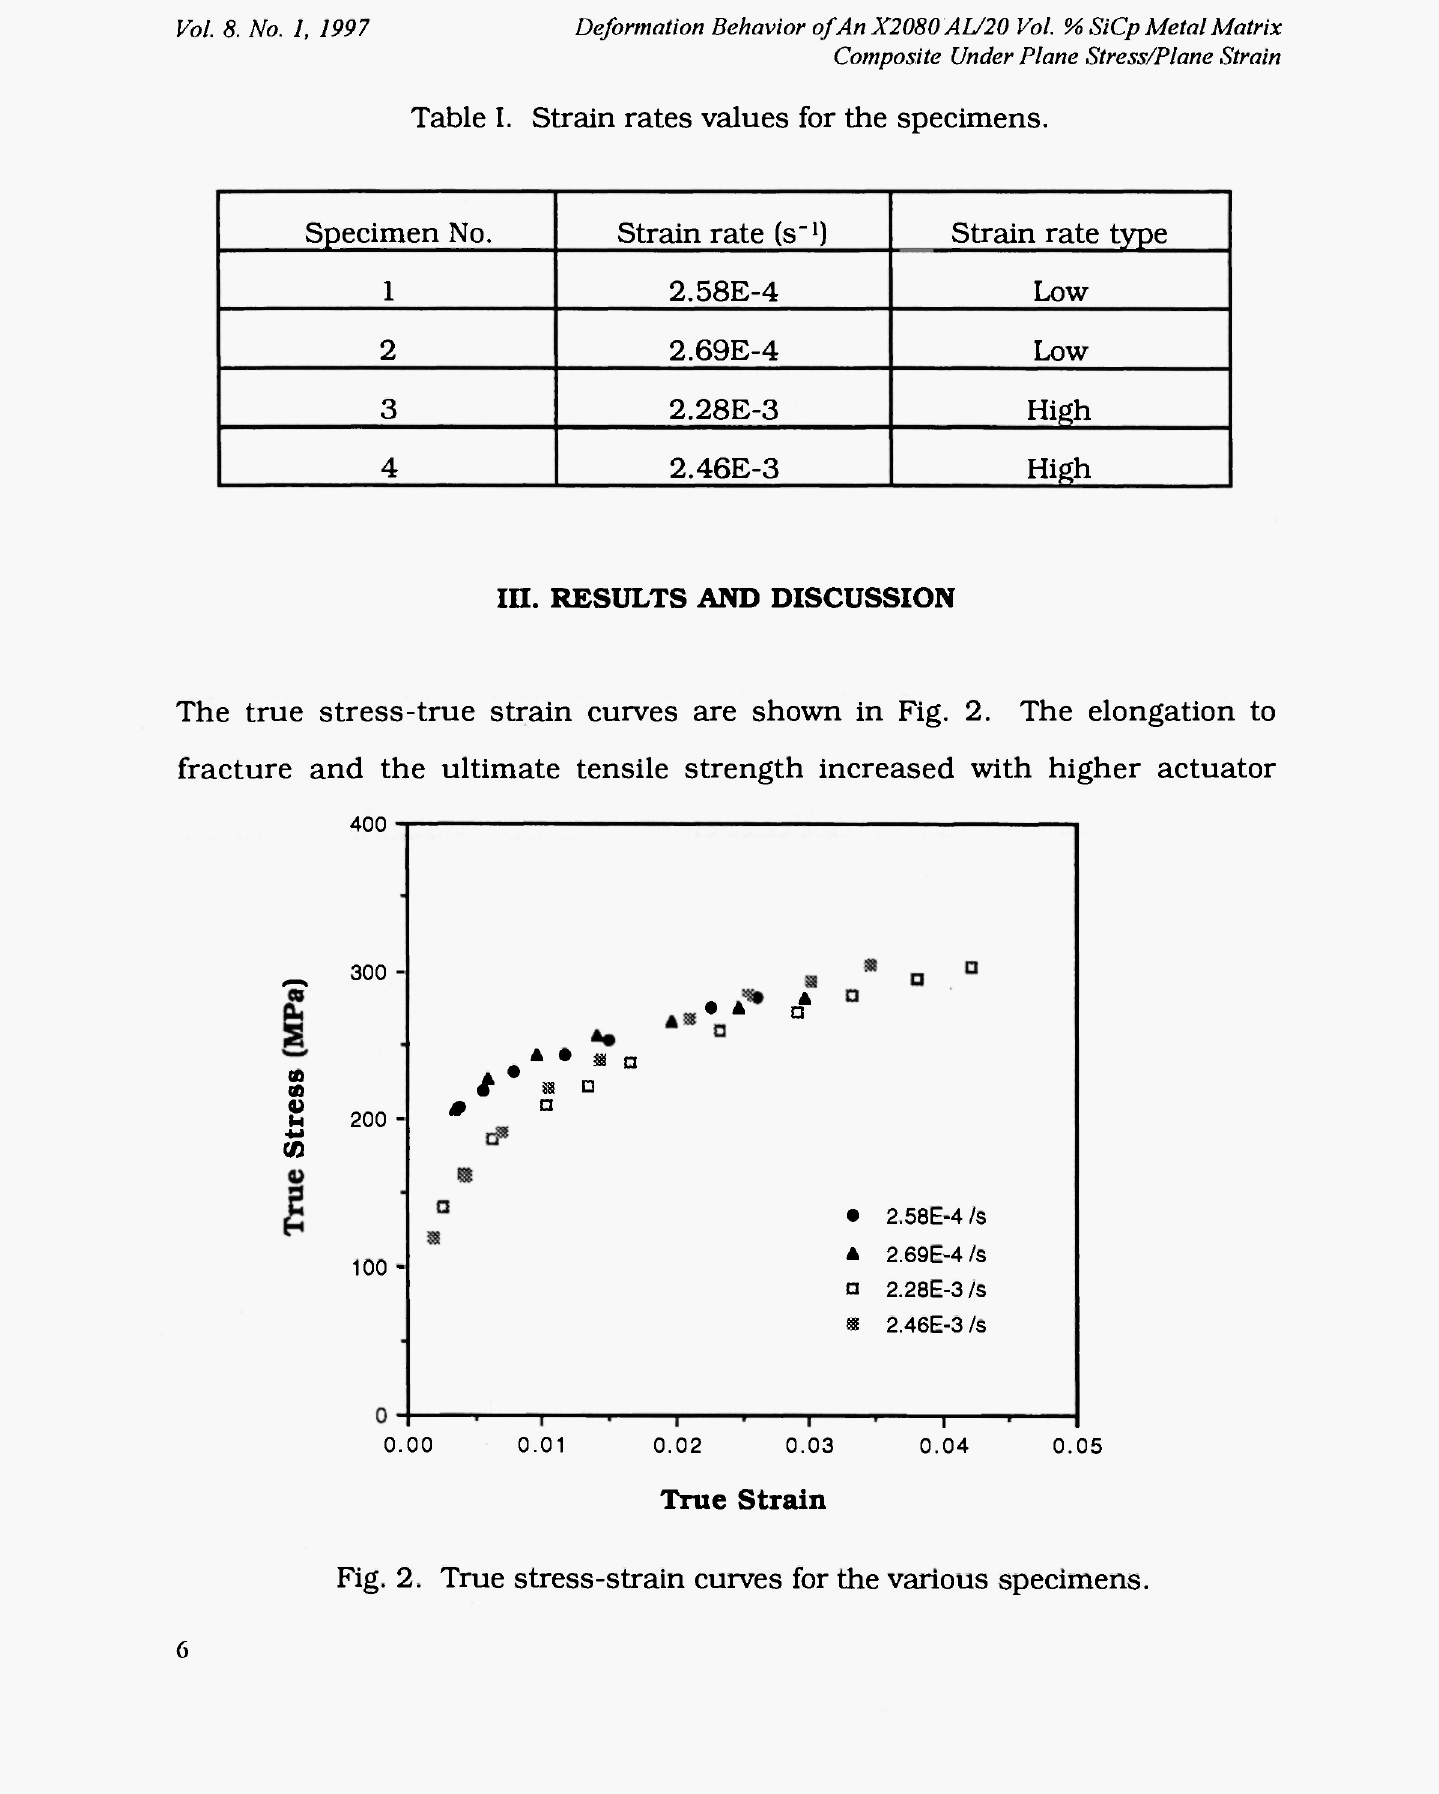
Fig. 2. True stress-strain curves for the various